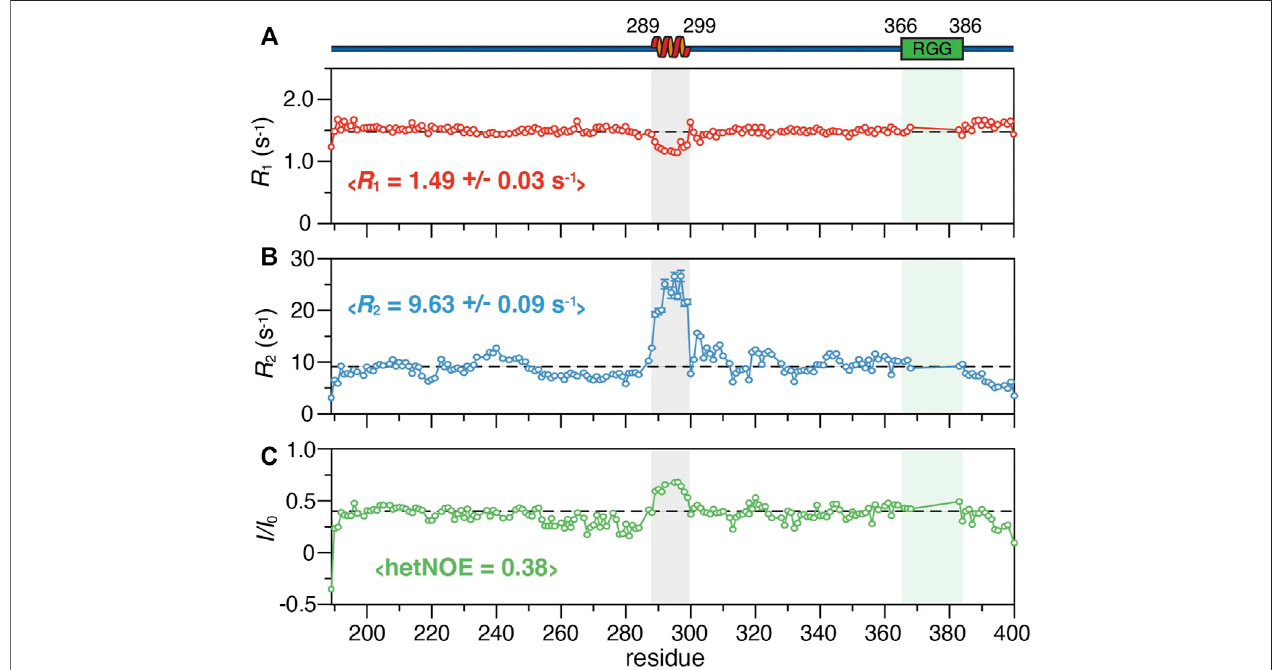
FIGURE 3 | 15 N relaxation parameters of SERBP1 189 – 400 including (A) R 1 and (B) R 2 rates, and (C) the 1 H- 15 N heteronuclear NOE plotted against the protein sequence.The dashed lines representthe average value for each experiment, also indicated in brackets. Acartoon representation of the α -helix identi fi ed from chemical shift information and relative position of the RGG boxes (green) is shown above the plots. The shaded boxes align the helical region and RGG box over all